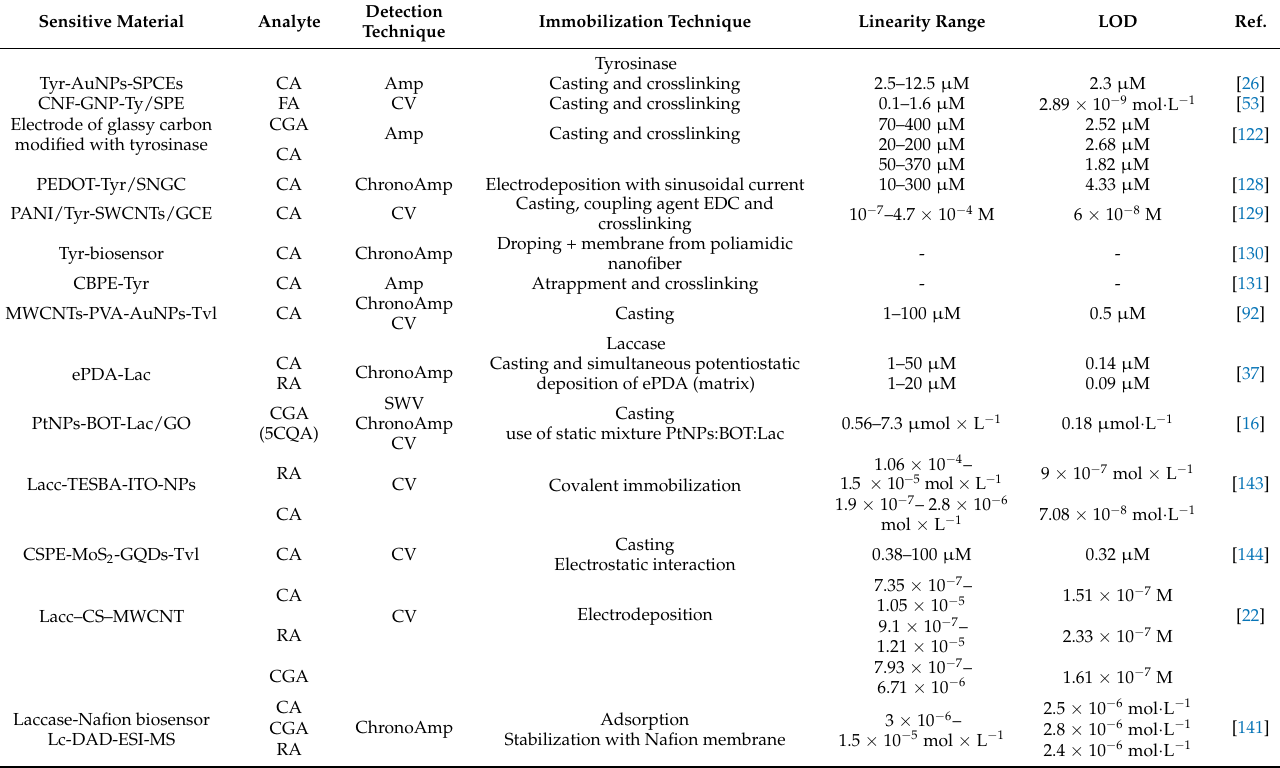
Table 1. The main biosensors based on tyrosinase and laccase, respectively, for the detection of HCs, electrochemical technique, enzyme immobilization technique, linearity range, and detection